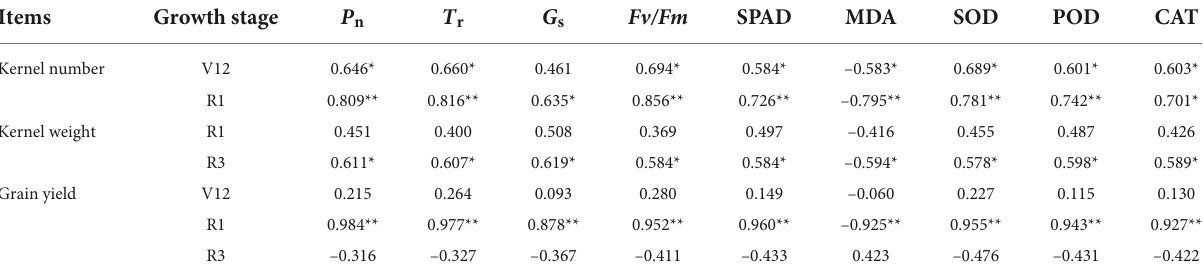
TABLE 3 Relationship between physiological parameters and yield traits at different sowing dates.